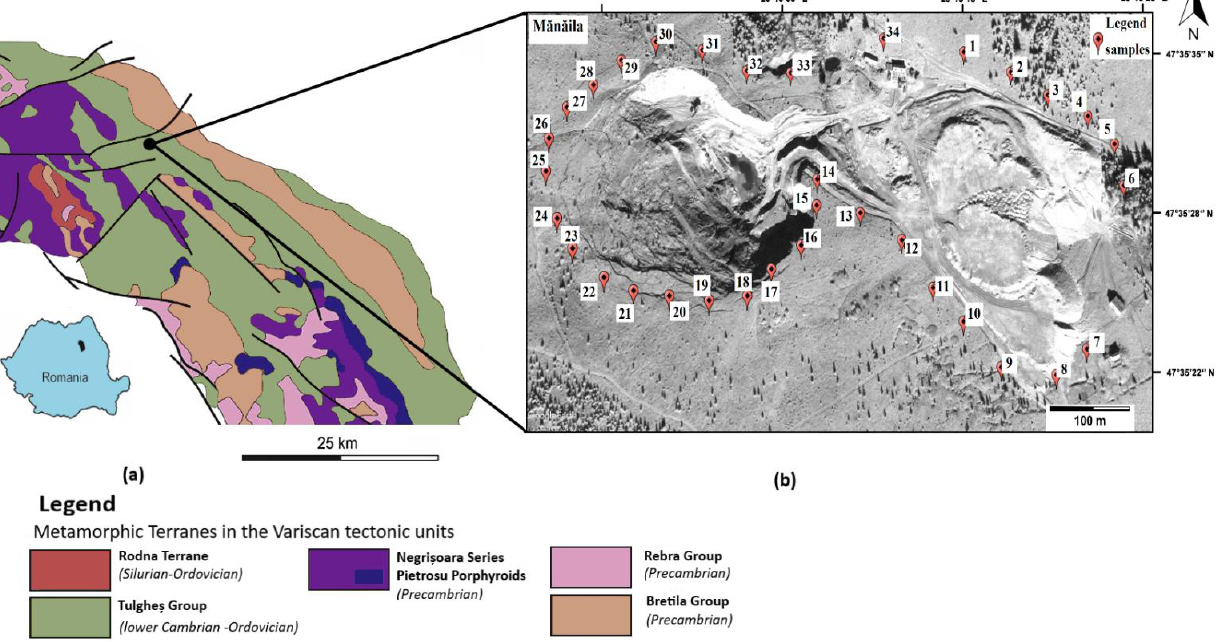
Figure 1. The Mănăila open-pit exploitation ( a ) geological map of the area, modified after [21] and ( b ) soil samples location using Google Map as base maps [22]. ( b ) soil samples location using Google Map as base maps